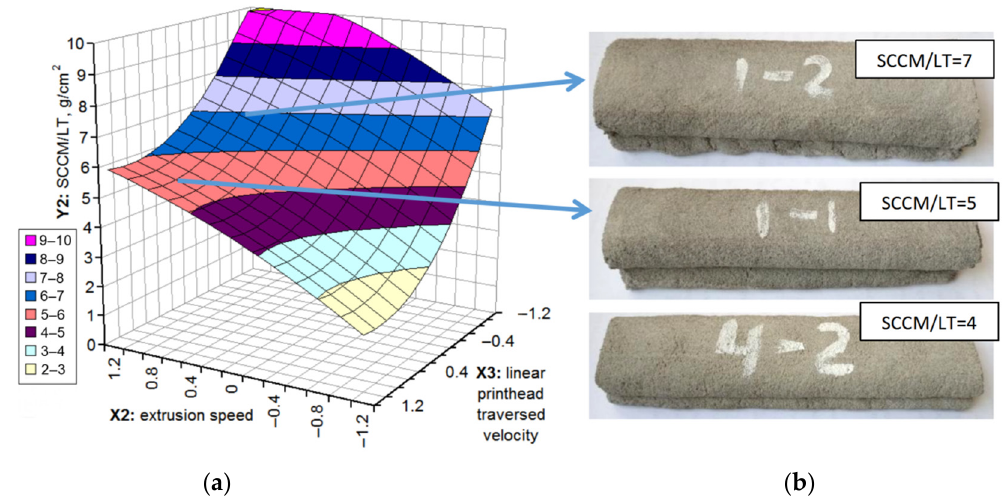
Figure 4. Effect of the screw speed and linear printhead traversed velocity of the former Y2 on the specific consumption of the mixture related to the layer thickness (at X1 = 0). ( a ) graphic representation of relationship between screw speed, linear printhead traversed velocity and specific consumption of the mixture; ( b ) visual assessment of SCCM/LT effect on the samples view. The length of the samples is 150 ± 5 mm.